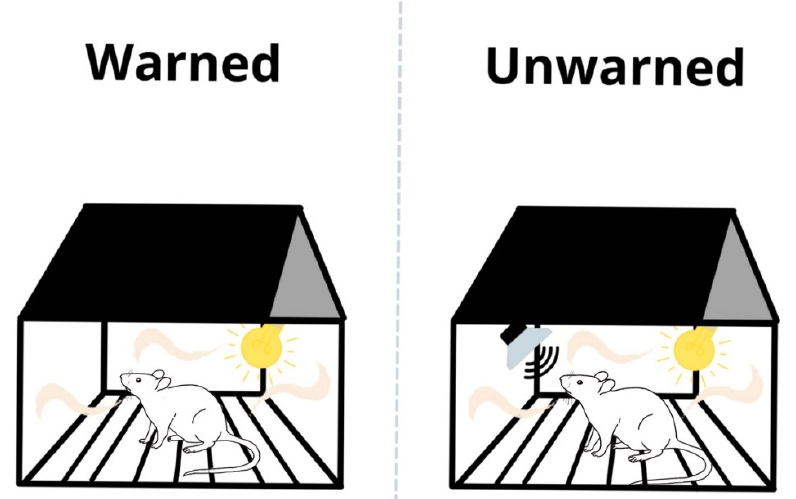
Figure 2. Illustration of the training: pre-exposure to the electric foot shocks. To exclude the rats’ aversive conditioning response, the training cage differed from the test cage in terms of smell, light intensity, and shape. Depending on the experimental group, ‘unwarned’ or ‘warned,’ (the group names are according to the test day procedure), a 1.75 kHz sound signaling a foot shock was emitted or not emitted, respectively.